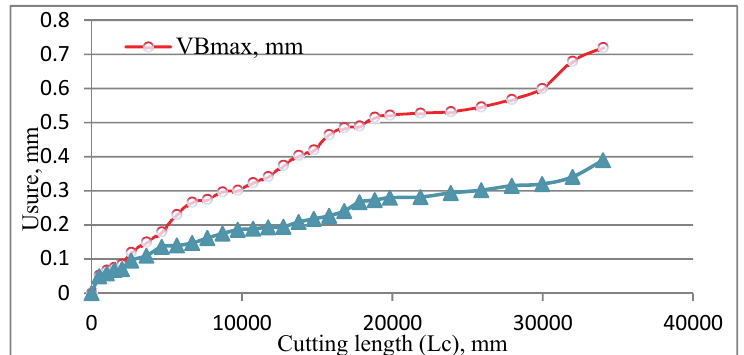
Fig. 14. Flank wear curves when machining at a 439.6m/min and a feed per tooth of 0.114 mm